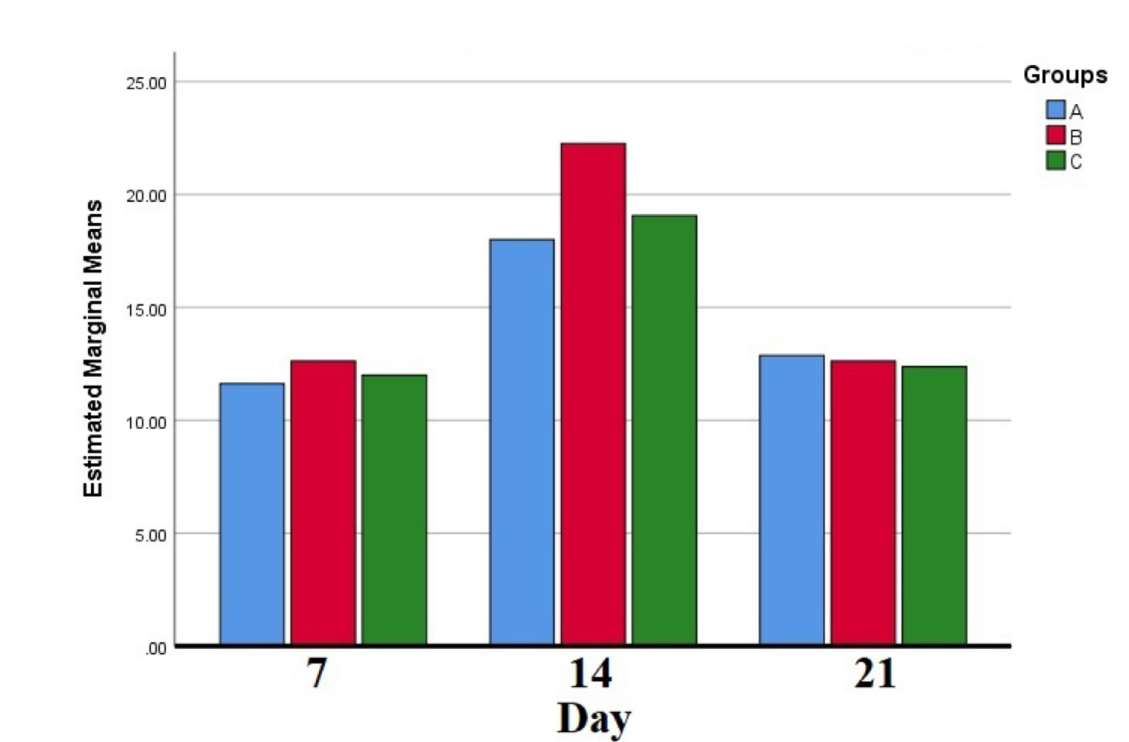
Fig. 4. Estimated marginal means of blood vessel count on day 7, 14, and